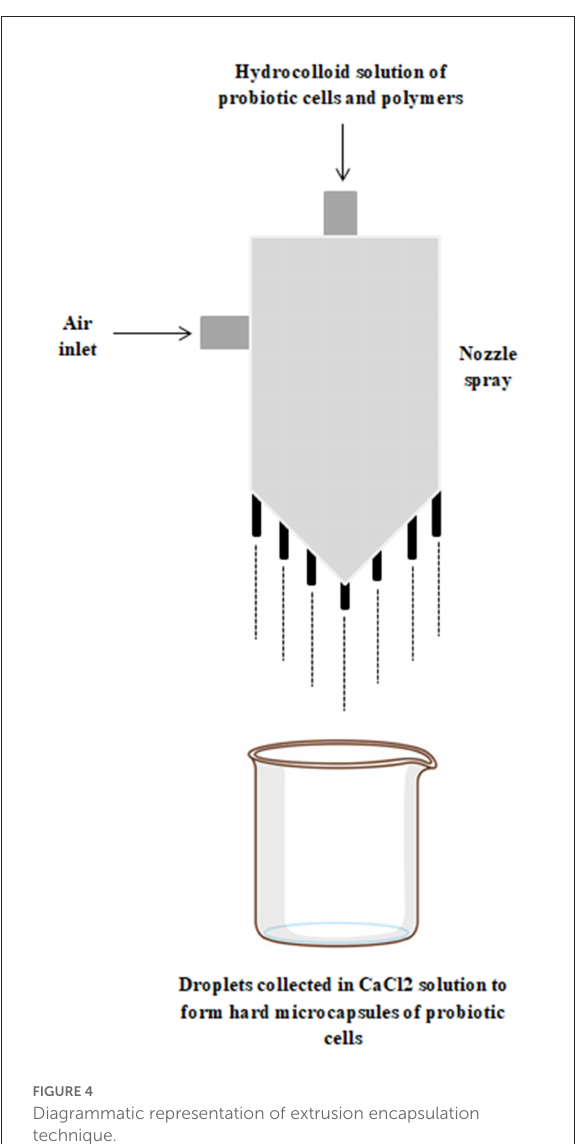
FIGURE4 Diagrammatic representation of extrusion encapsulation